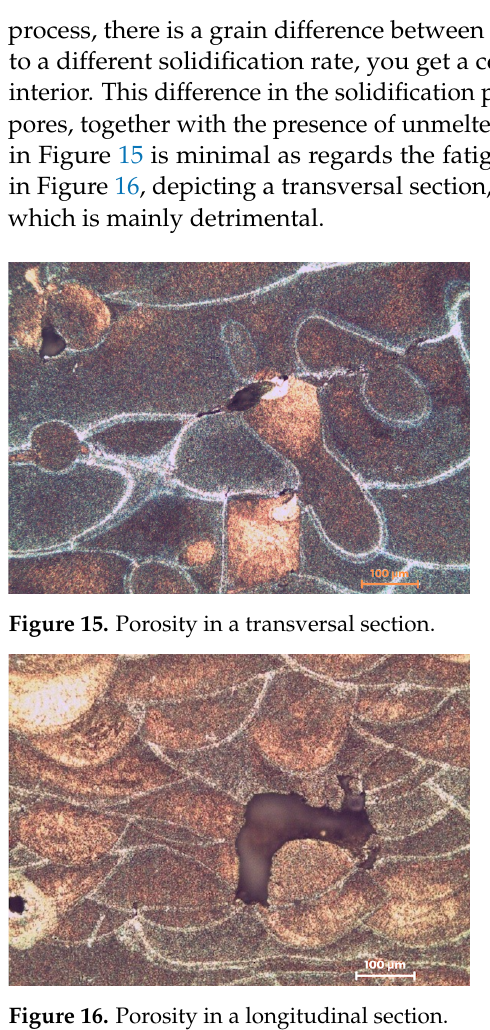
Figure 16. Porosity in a longitudinal